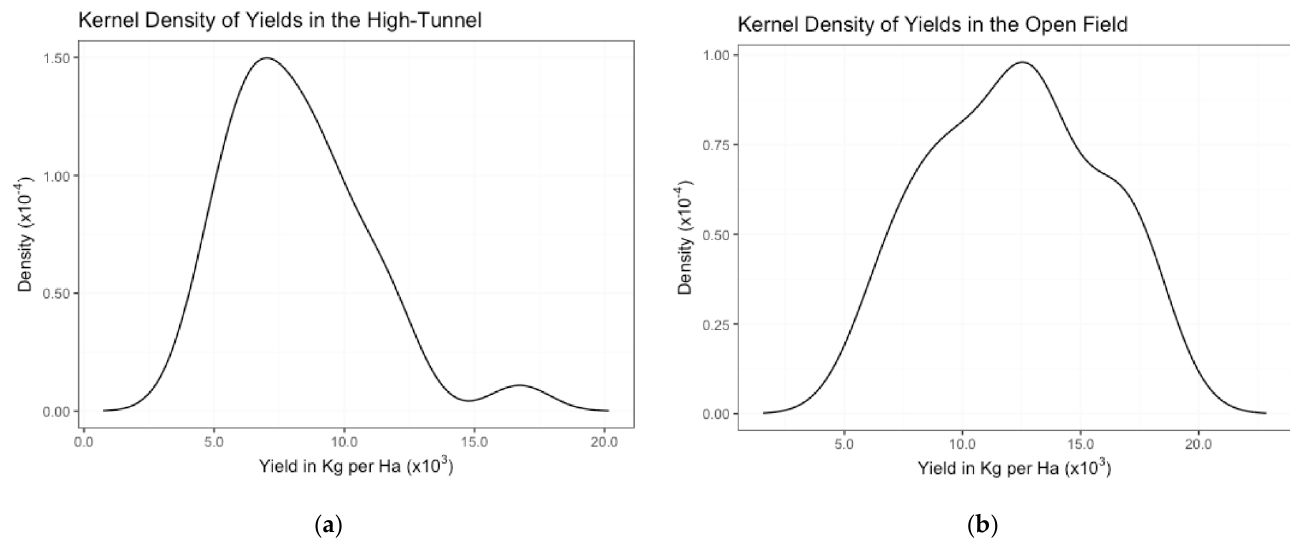
Figure 2. Kernel density estimates for high tunnel ( a ) and open-field yields ( b